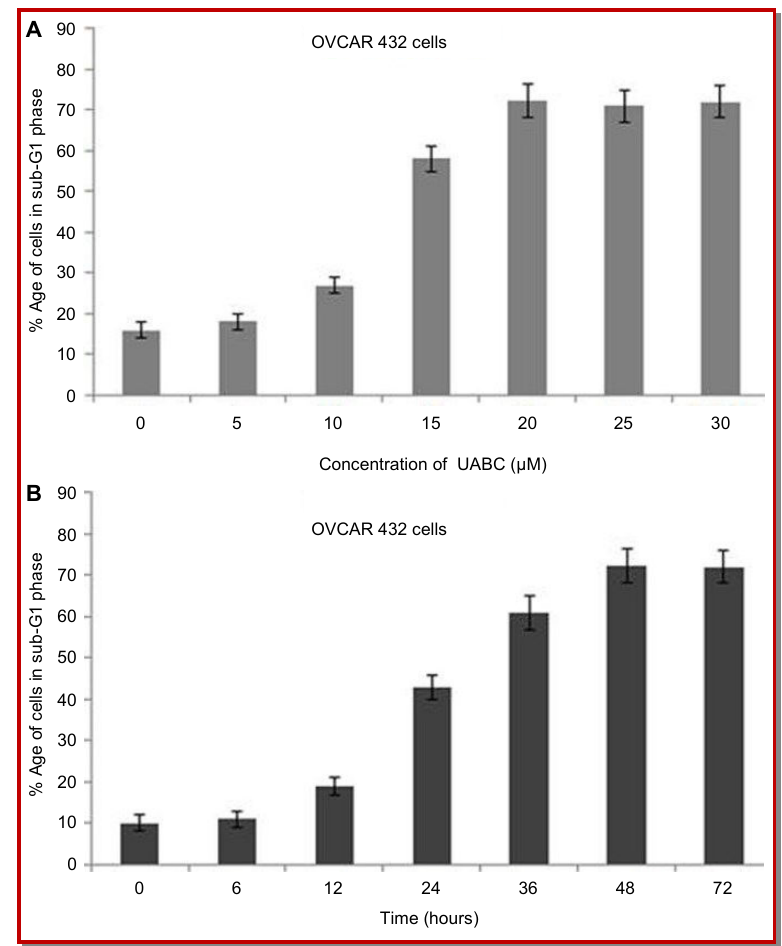
Figure 2: Cytotoxic activity of UABC against OVCAR 432